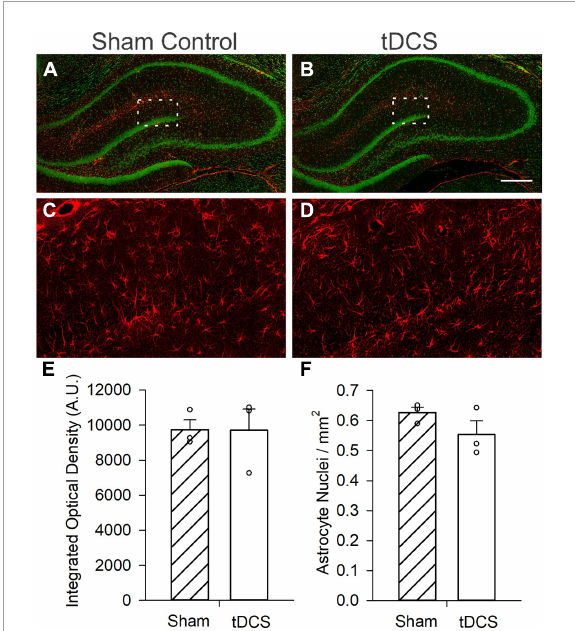
FIGURE3 Effects of transcranial direct current stimulation (tDCS) on astrocyte activation. Micrograph images from small confocal stacks ( z = 9 × 1 µ m steps) with astrocytes revealed with GFAP immunoreactivity (Red) and neurons revealed with green fluorescent Nissl staining. (A) Image of hippocampus slice from a control (sham) rat. (B) Image of hippocampus slice from a rat administered one round of tDCS. Scale bar = 400 µ m (C) Enlarged image from a control (sham) rat showing astrocytes. Area enlarged is indicated as the white box in A. (D) Enlarged image from a rat administered one round of tDCS showing astrocytes. Area enlarged is indicated as the white box in B. (E) Bar graph showing no significant effect of tDCS on integrated optical density ( p = 0.985, n = 3 rats, t -test) (F) Bar graph showing a minor decrease in astrocyte nuclei per mm 2 , effect was not statistically significant ( p = 0.211, n = 3 rats, 3 slices per rat, t